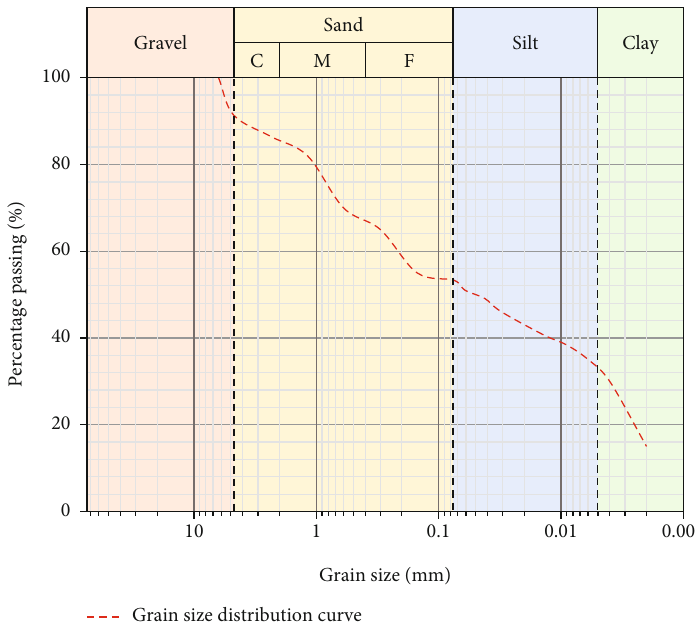
Figure 1: Grain size distribution of granite residual soil (GRS).